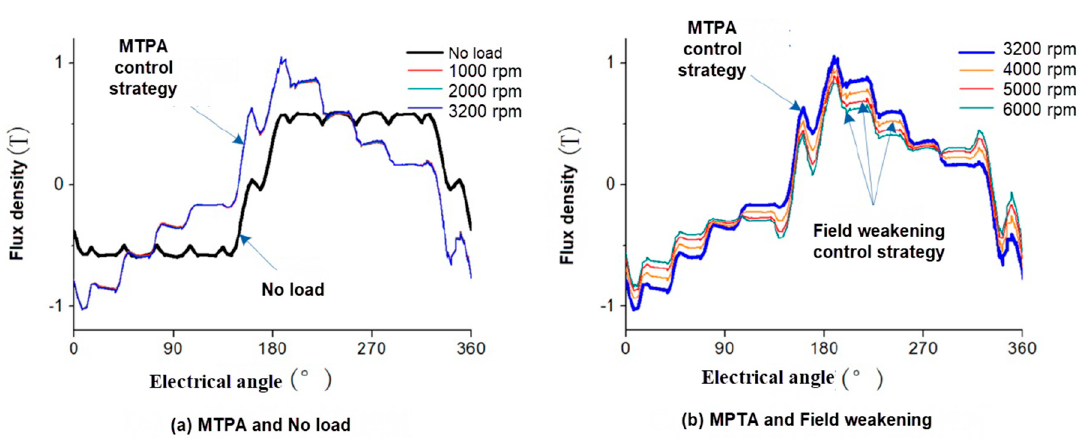
Figure 8. The air gap flux density under the armature reaction with considering the magnetic field of the permanent magnet.